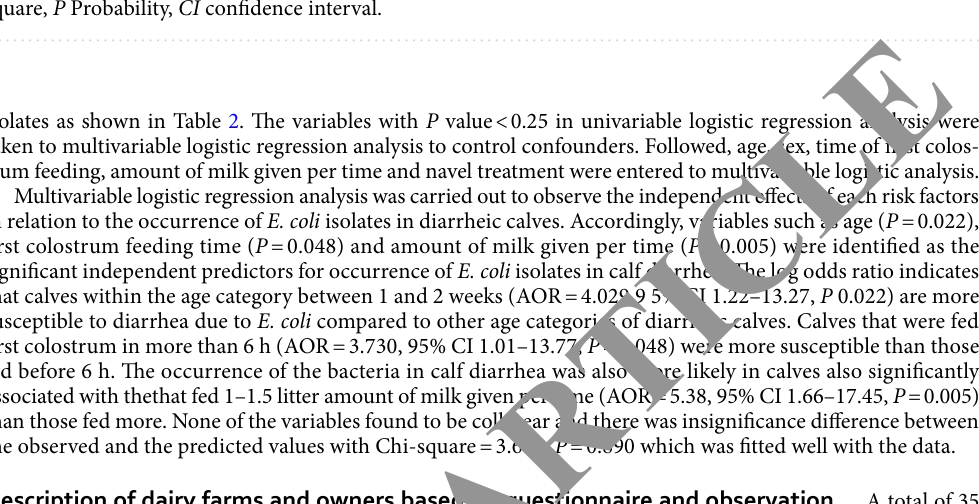
Table 3. PCR detection rate of virulence genes in E. coli isolates in diarrheic calves and children. χ 2 Chi square, P Probability, CI confidence